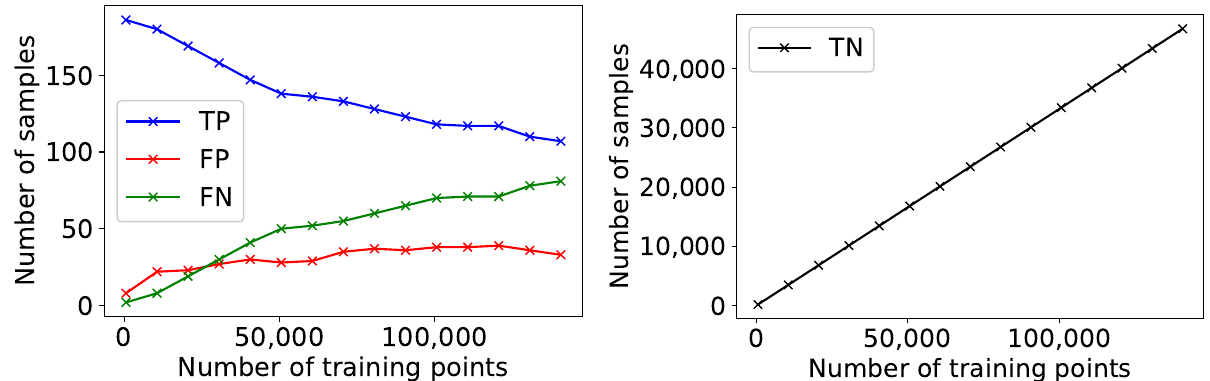
Figure 3. Learning curves for the SVM training, showing the TP, FP and FN ( left ) and the TN ( right